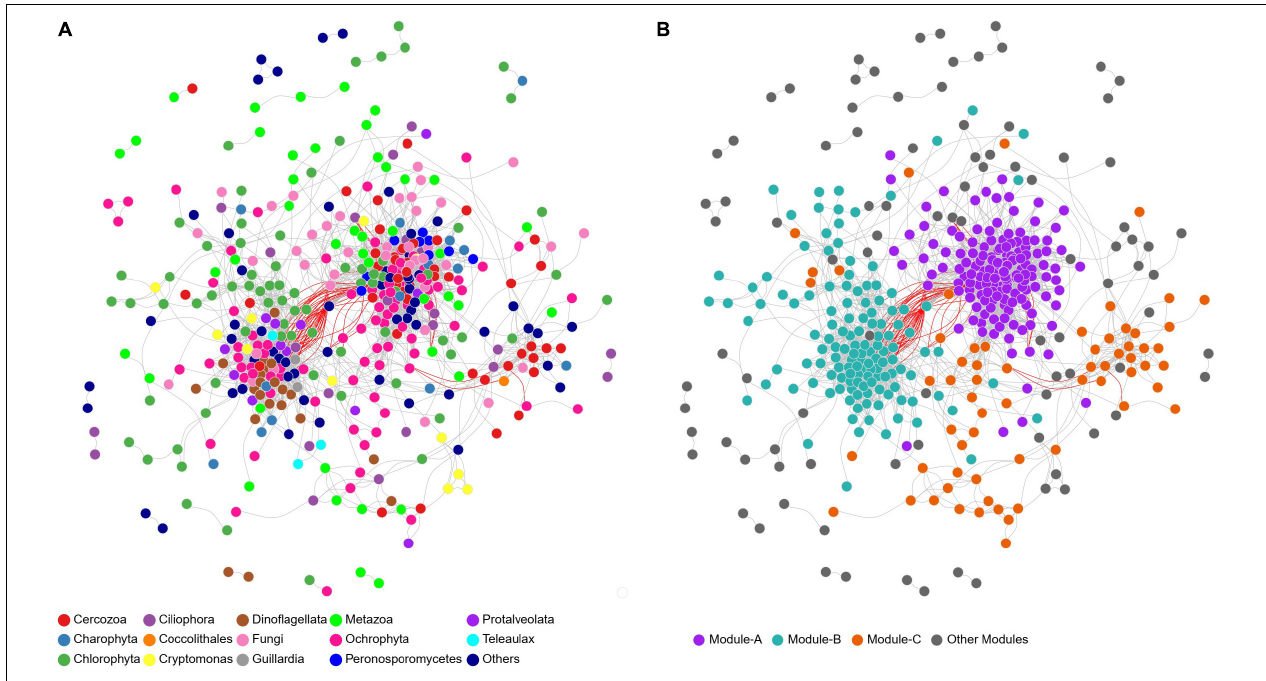
FIGURE 4 | Co-occurrence network of microeukaryotic communities in the whole area colored by (A) major lineages and (B) major modules (modules have more than 50 nodes). Circle nodes represent OTUs. Edges represent Spearman correlations (only strong and significant relationships with Spearman’ s r > 0.8 or r < –0.8 and P < 0.05 are shown). The gray and red lines indicate positive and negative correlations,